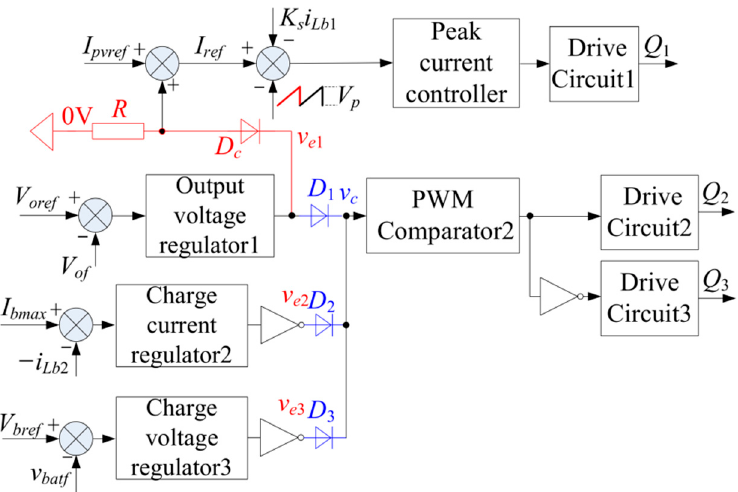
Figure 4. The control system of PVDCM.